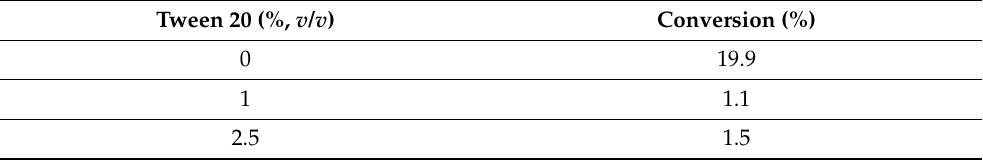
Table 3. Hydrolysis of ibuprofen methyl ester to S -ibuprofen with KLEST-3S varying Tween 20 amounts. Enzyme units, 15. Cosolvent, 10% ( v / v ) DMF. Temperature 47 °C; time, 24 h.